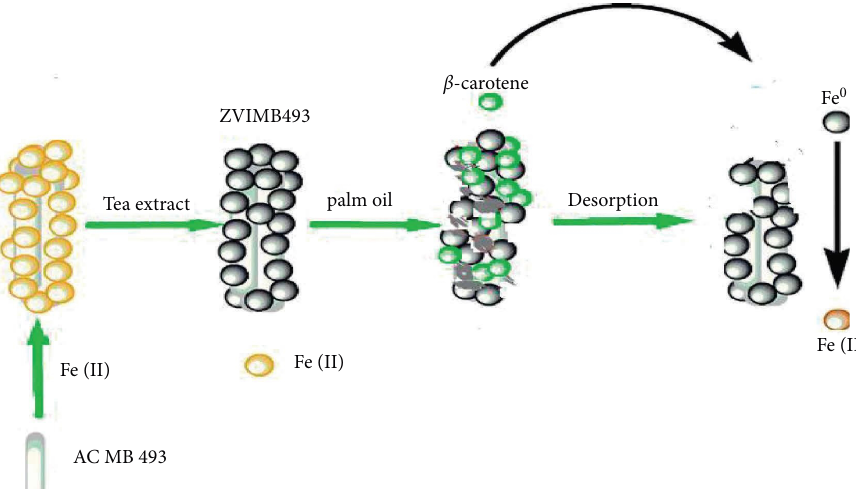
Figure 1: Schematic illustration of the immobilization of nanoscale zero valent iron particles on ACMB 493 and proposed mechanism for β- carotene desorption by ZVI MB